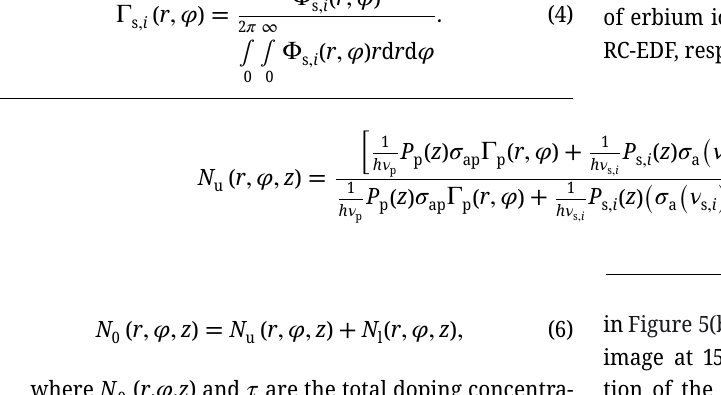
Figure 4: Simulated parameters of the RC-EDF. (a) Absorption and emission cross-sectional area of fluorescence photons with the OAM (b) Mode pattern and interferogram, (c) normalized intensity of OAM